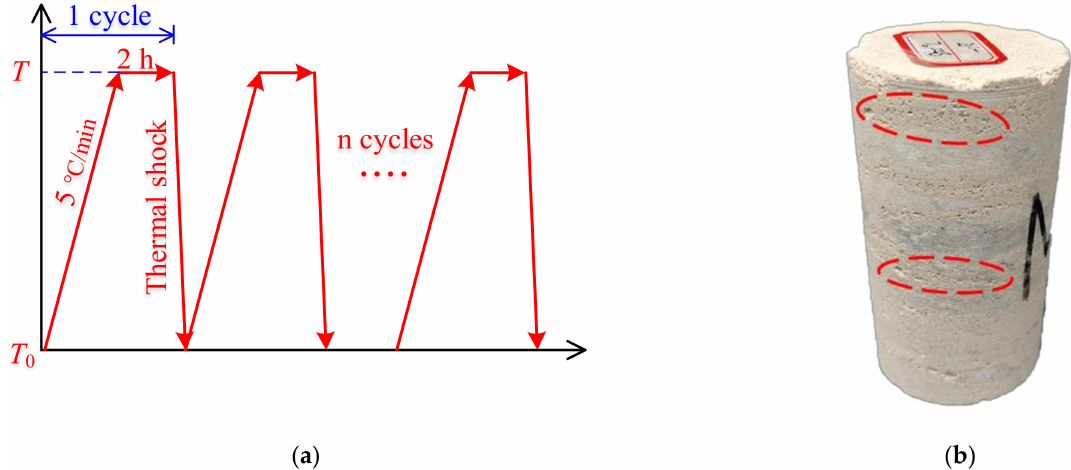
Figure 2. ( a ) Schematic diagram of cyclic thermal shock; ( b ) Marble specimen underwent thermal shock treatment of 800 ◦